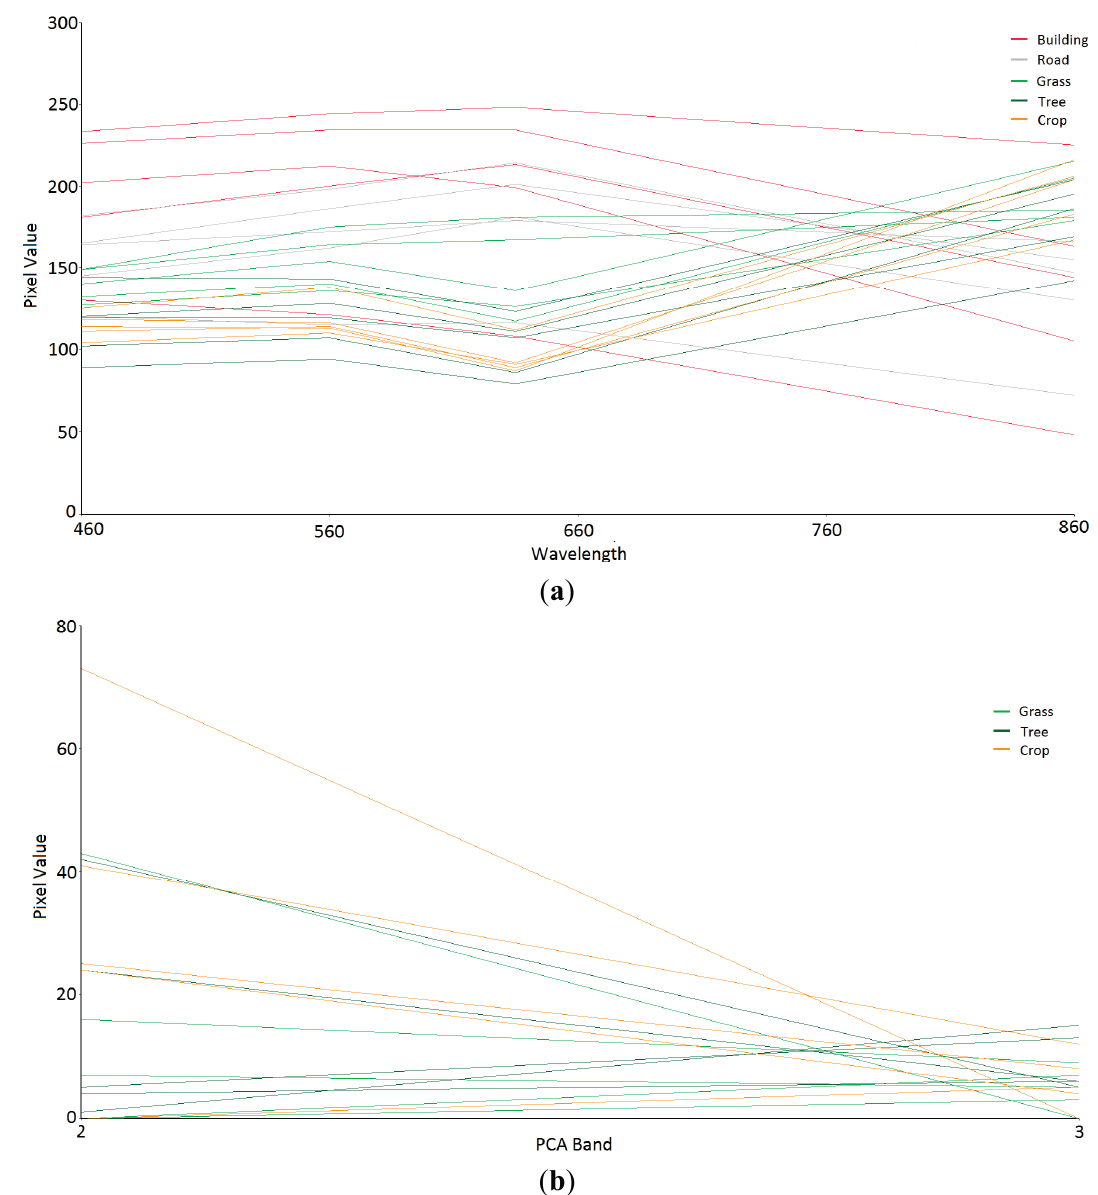
Figure 3. The image spectral response profiles showed that mixtures of spectral characteristics exited in the class of buildings and roads, and between different vegetation types in the original aerial photography bands and principal component analysis (PCA) bands. Lines in the figures with different colors represent different land-cover types. ( a ) The mixture in the spectral response of building and road objects, and the mixture in the spectral response of trees, crop and grass objects of 4-band aerial photos. ( b ) The mixture in the spectral response of trees, crop and grass objects of PCA